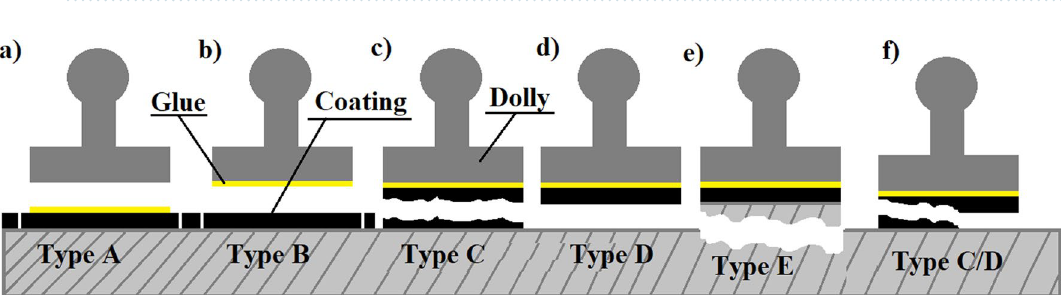
Figure 10. Mineral coating in the oily substrate: ( a ) MI samples exposed to air and oven drying ( b ) MI samples exposed to air drying.